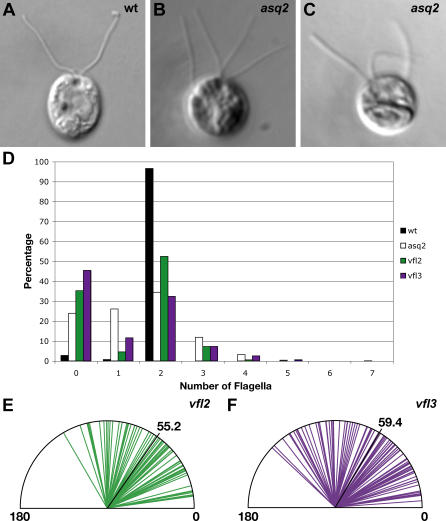
Mutants with Variable Numbers of Centrioles Also Have Centriole Positioning Defects(A) DIC image of a wt cell. wt cells have two flagella located at the apical side of the cells.(B and C) DIC images of asq2 cells. asq2 cells have variable numbers of centrioles and therefore make variable numbers of flagella. Some centrioles are randomly localized, whereas some are in the correct apical position.(D) Distribution of flagellar number in asq2 cells is reminiscent of the vfl (variable flagellar number) phenotype. asq2 cells (white) have a mean of 1.46 ± 1.1 flagella per cell (n = 1,274). This distribution is similar to that of vfl2 cells (green; mean = 1.33 ± 1.05, n = 593) and vfl3 cells (purple; mean = 1.12 ± 1.8, n = 466), but is in contrast to wt cells, which make two flagella (black; mean = 1.94 ± 0.34, n =1,005).(E) vfl2 cells, previously identified as defective in centriole segregation, have a mean θcentriole of 55.2 ± 28.8° (n = 64).(F) vfl3 cells, defective in mother–daughter centriole cohesion, have a mean θcentriole of 59.4 ± 35.2° (n = 90).